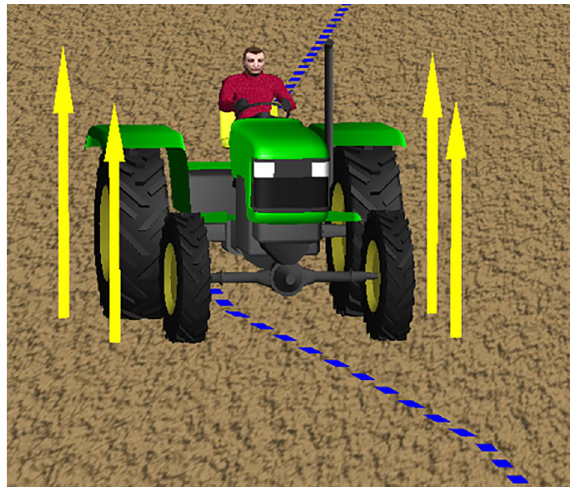
Figure 27. Tractor operating in farm fields.